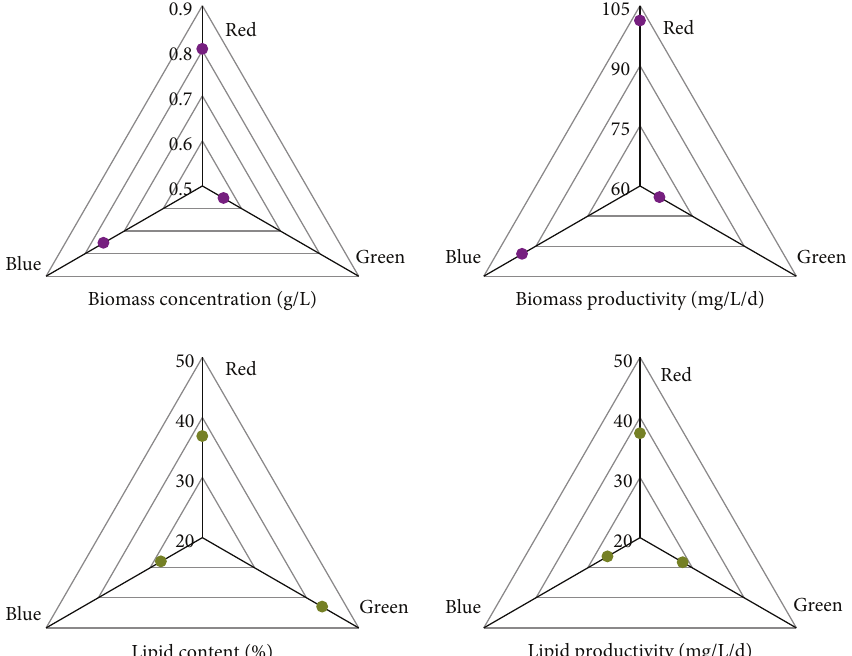
Figure 3: Biomass concentration and lipid contents of Golenkinia SDEC-16 on day 7 under red, green and blue lights.